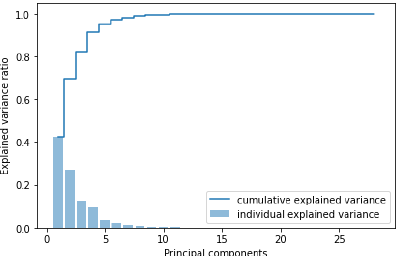
Figure 5. Explained variance ratio of the principal components Based on Figure 5, using only the first five principal